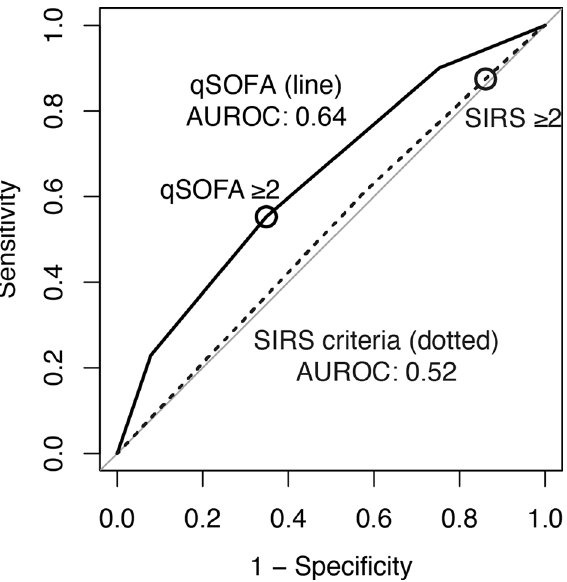
Figure 2. Prediction of in-hospital mortality using the tested scores. Receiver operating characteristics analysis and the prediction of in-hospital mortality using the tested scores (line and dotted line) with the given threshold (circle). qSOFA quick sequential organ failure assessment, SIRS systemic inflammatory response syndrome, AUROC area under the receiver operating characteristic